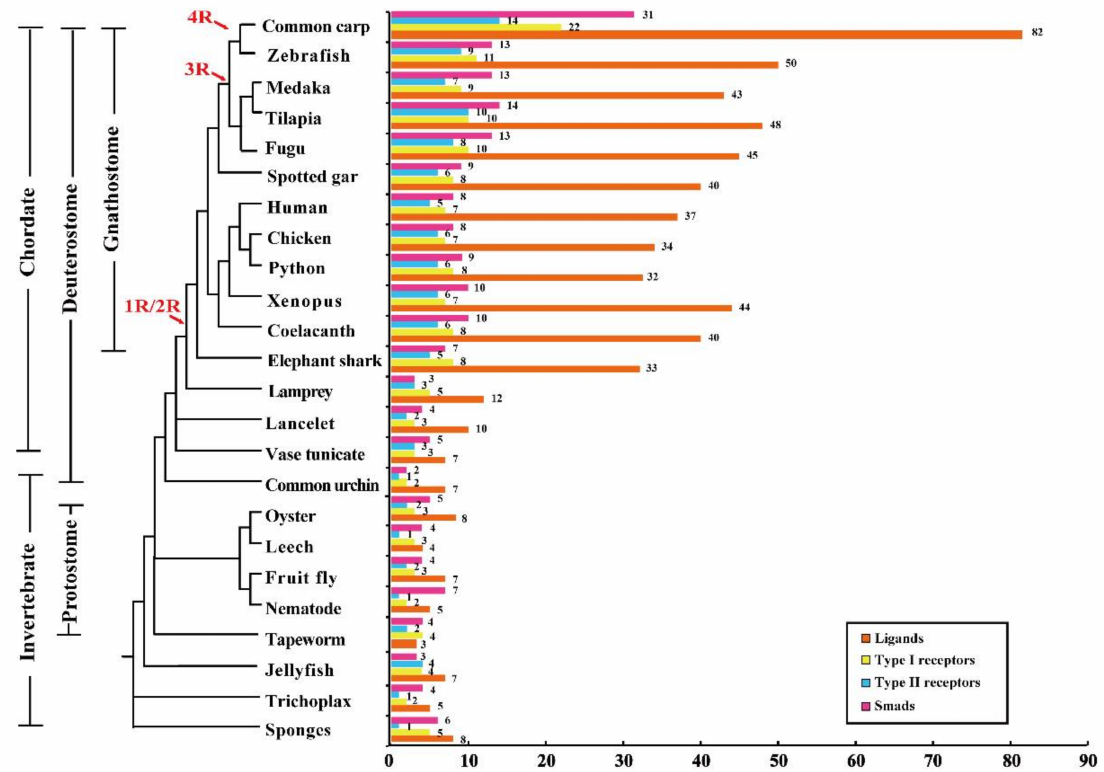
Figure 1. Phylogenetic relationship of 24 representative animals analyzed and numbers of transforming growth factor β (TGF- β ) pathway gene. 1R, 2R, 3R and 4R indicate the four rounds of WGD that occurred during vertebrate evolution. The complete TGF- β pathway was first appeared in sponges, and the pathway members are universally present in all